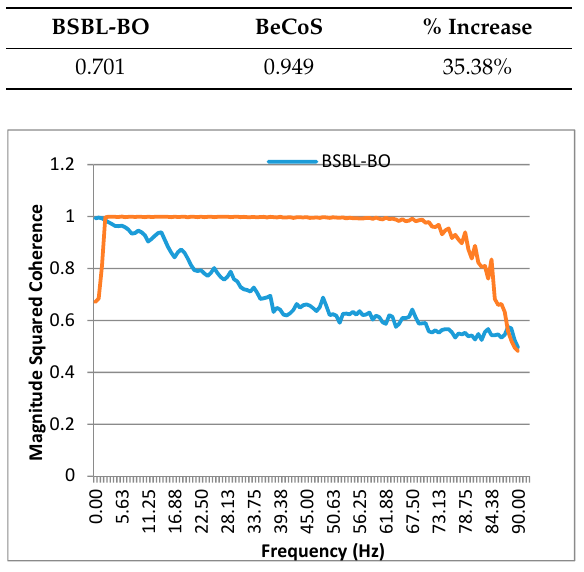
Table 1. Comparison of block sparse Bayesian learning-bound optimization (BSBL-BO) and bioinspired electroceptive compressive sensing (BeCoS) coherence values.